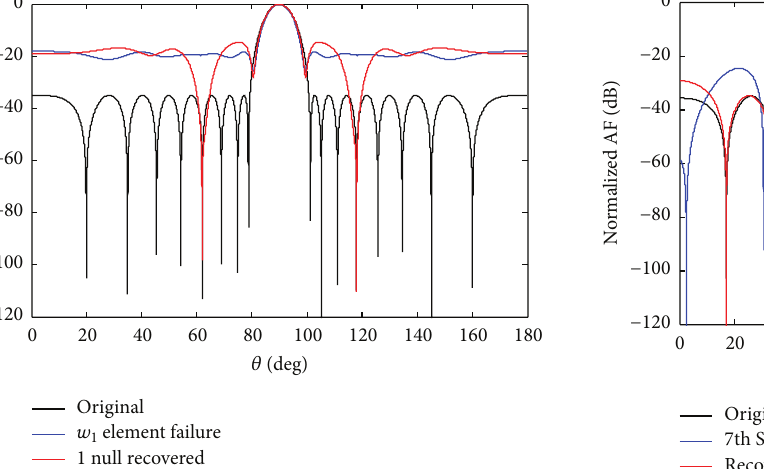
Figure 16: The corrected pattern with main beam pointing at 110 ∘ with recovered